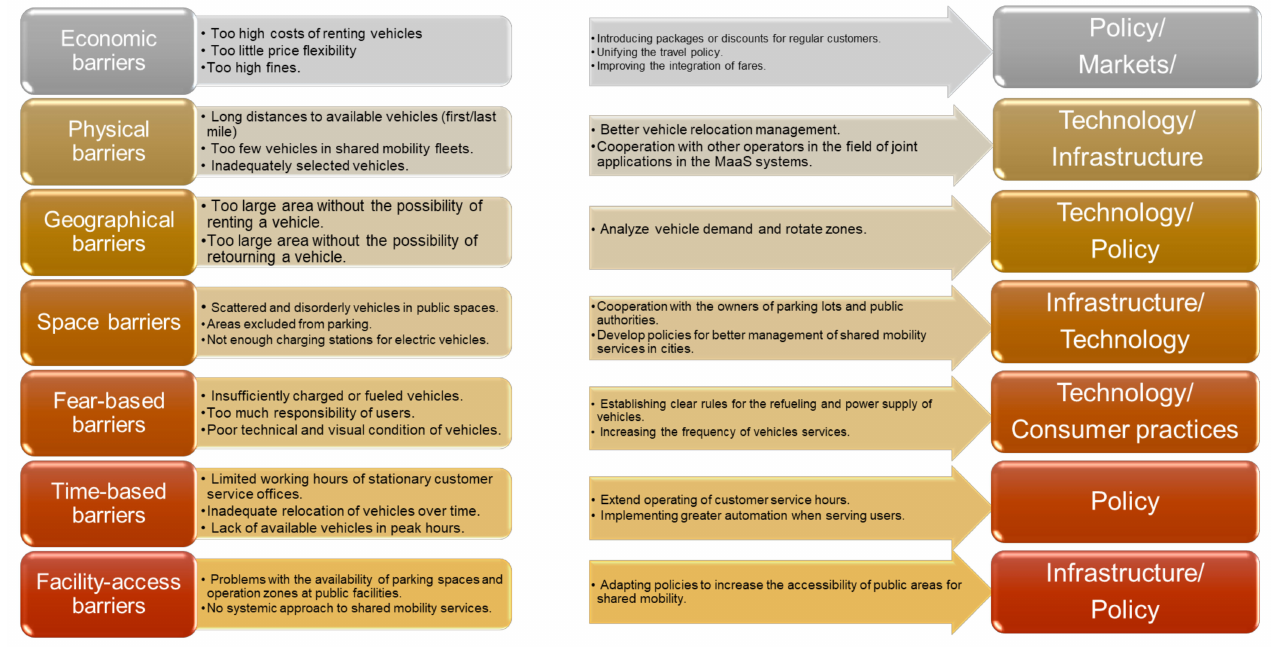
Figure 4. Shared mobility barriers and socio-technical